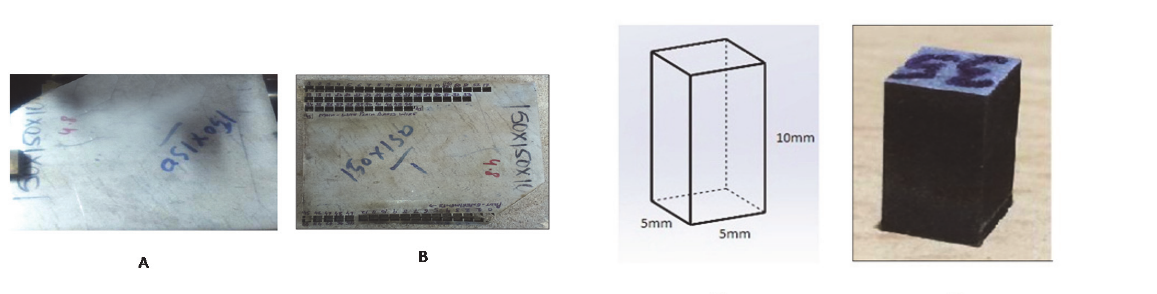
Fig. 1. Workpiece (Inconel 825) A) before machining B) after machining